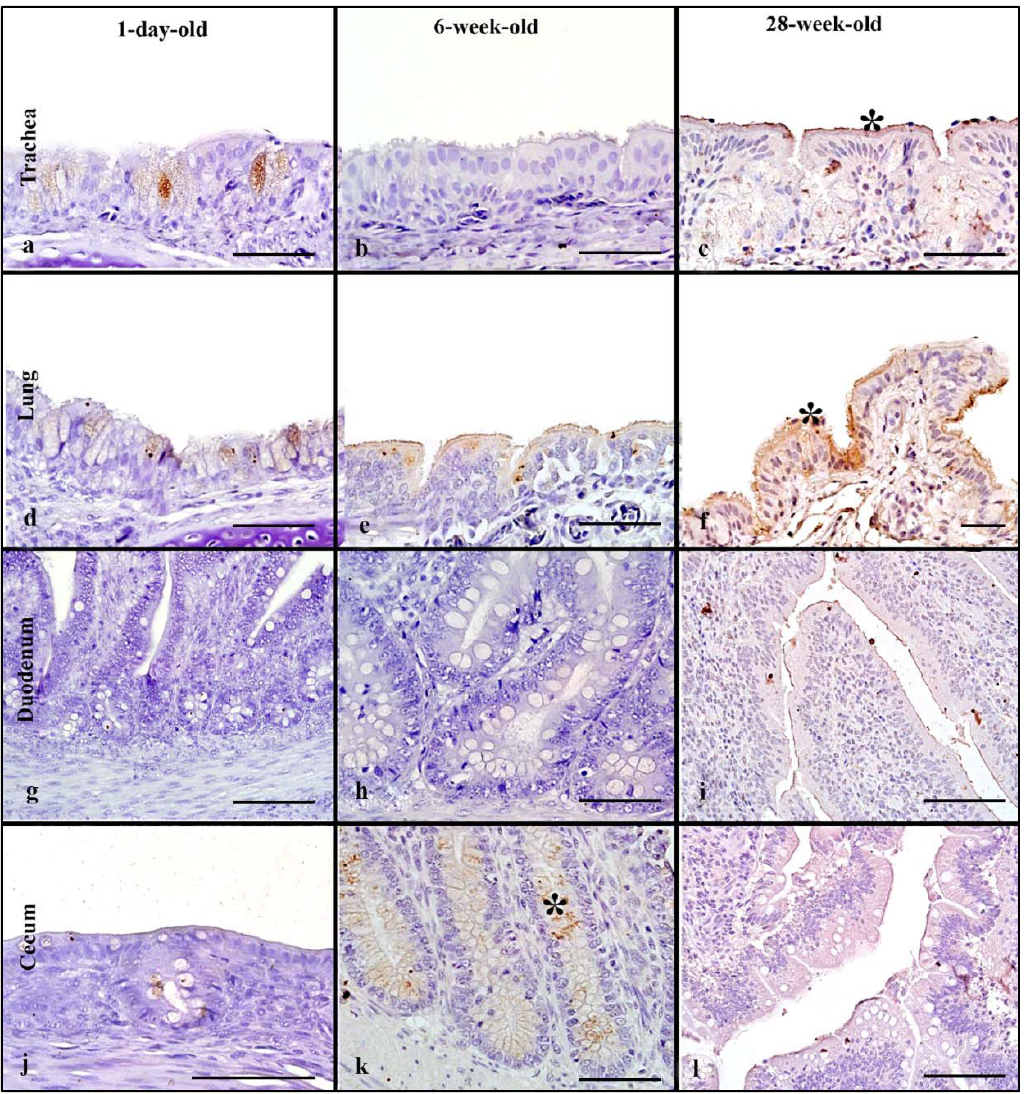
Figure 9. Surface area of LPAIV H5 rHA binding in chickens of different age groups, visible as dark brown staining using DAB-HRP via protein histochemistry, denoted by asterisk (*). Note generally mild levels of rHA binding in all tissues of the age groups to the respiratory epithelial cells ( a , c – e ), enterocytes ( i ) and goblet cells ( j , k ). Scale bar is 50 µm.